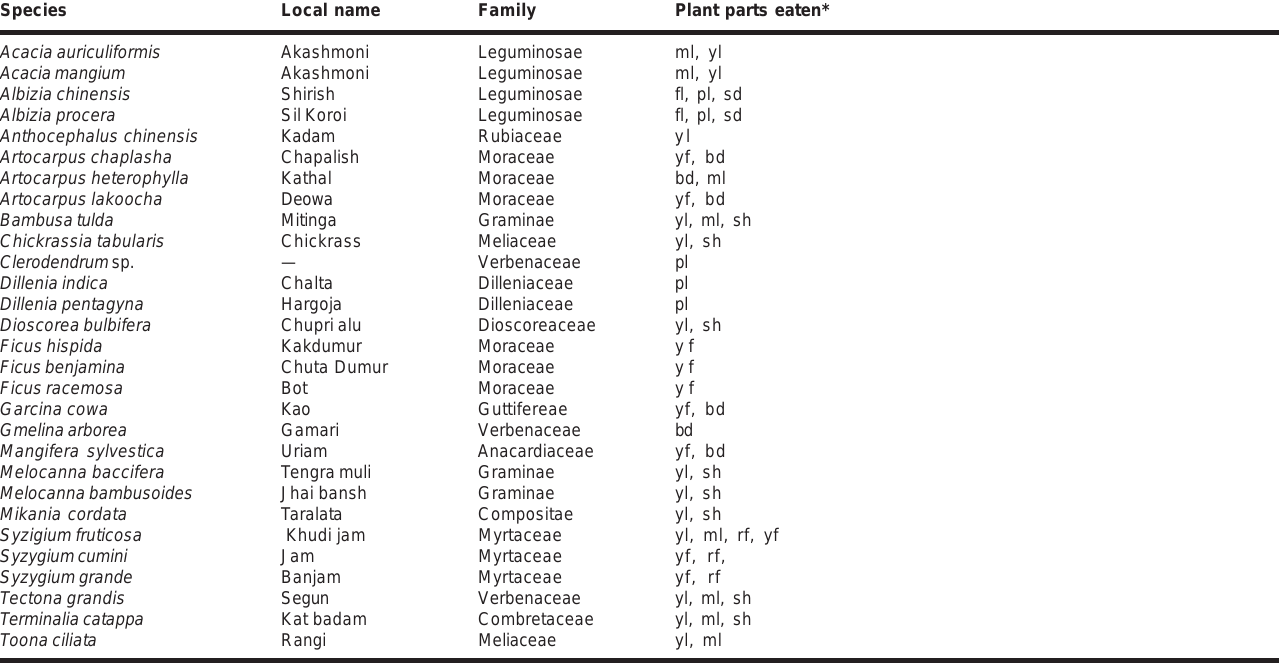
Table 1. Plants species used by Trachypithecus phayrei Species